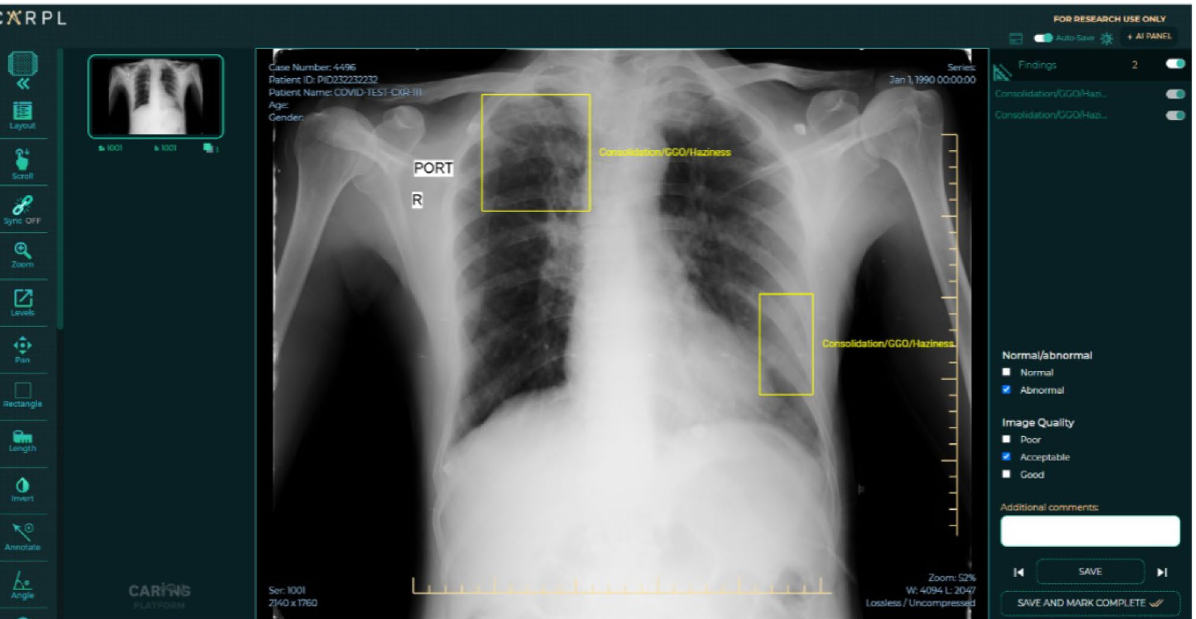
Figure 3. A snippet of the CARPL platform used for annotation and validation. (Image courtesy: CARING,